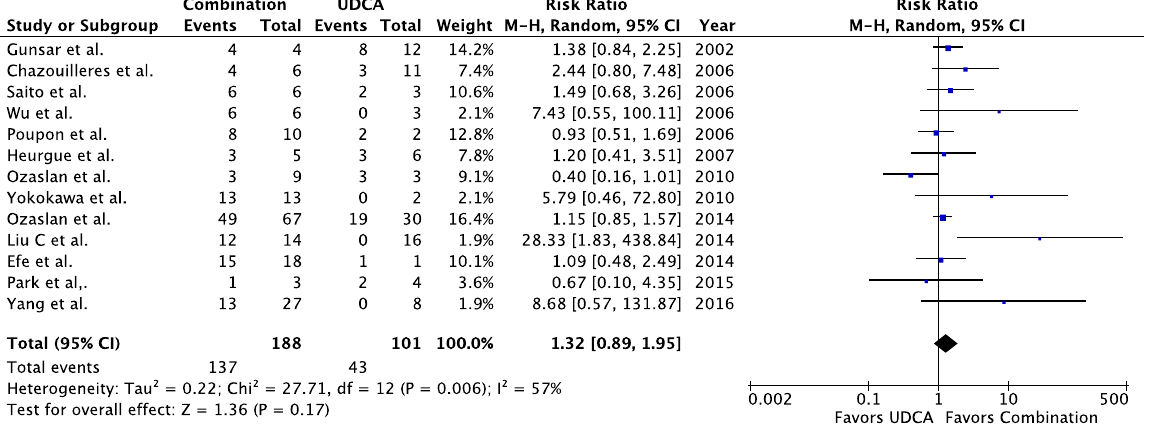
Figure A2. Biochemical improvement in AIH-PBC patients treated with combination therapy vs. UDCA alone, including only those studies in which combination therapy consisted of UDCA + corticosteroids ± AZA (i.e., no patients were treated with MMF, or with a combination of UDCA and antimetabolite therapy without corticosteroids). UDCA = ursodeoxycholic acid, AZA = azathioprine, MMF = mycophenolate mofetil. J. Clin. Med. 2020 , 9 , x FOR PEER REVIEW